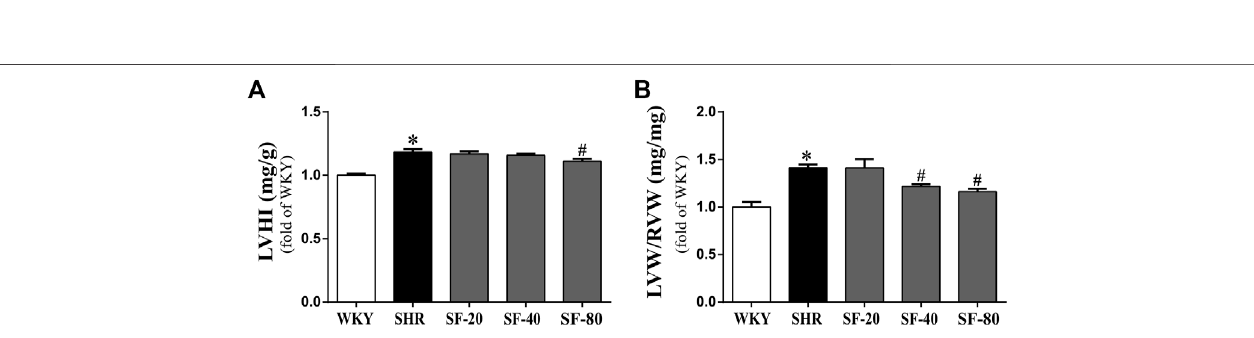
FIGURE 3 | SF can decrease the left ventricular hypertrophy index in SHRs. (A) Ratio of LVHI. ( n (cid:1) 10). (B) ratio of LVW/RVW. ( n (cid:1) 10). Data are presented as mean ± SEM. *signi fi cantly different from WKY at p < 0.05; # signi fi cantly different from SHRs at p < 0.05.